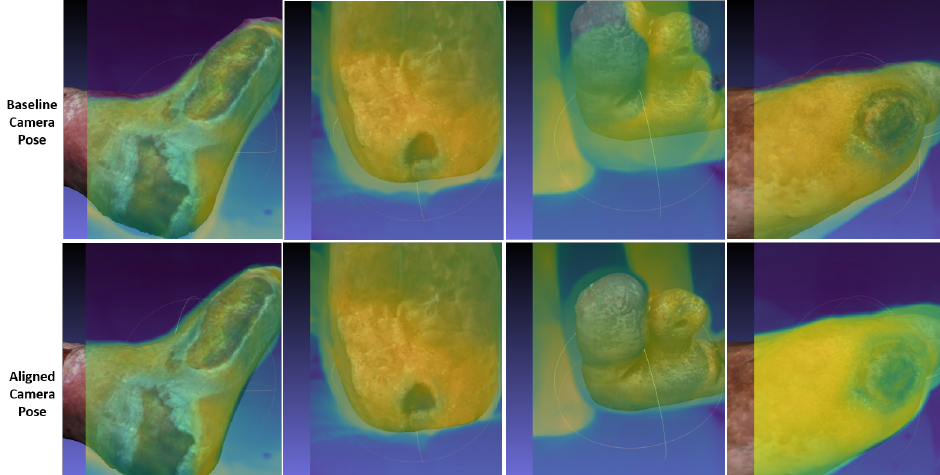
Figure 7. Illustration of the 2D thermal images overlaid onto the 3D model according from camera view: ( top ) given by the baseline camera pose and ( bottom ) after the proposed adjustment in camera pose. A better alignment of the skin edges is observed when using the adjusted thermal camera